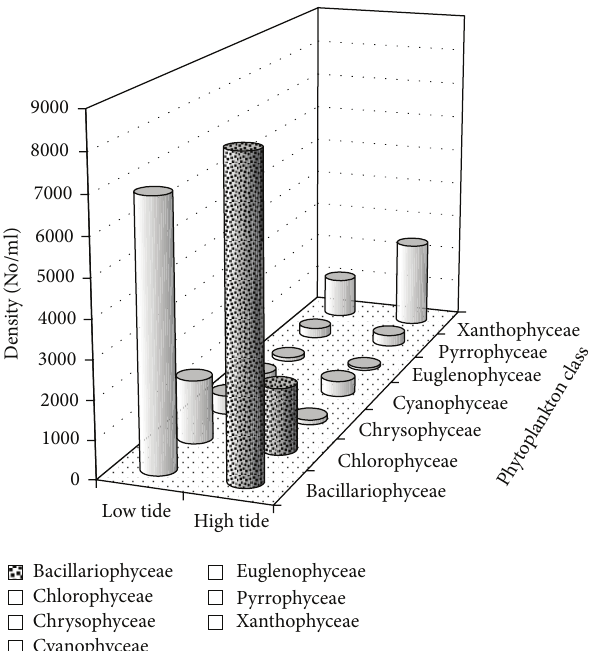
Figure 3: Variation of phytoplankton density. Variations of phyto- plankton parameters in relation to tide in Okpoka Creek.